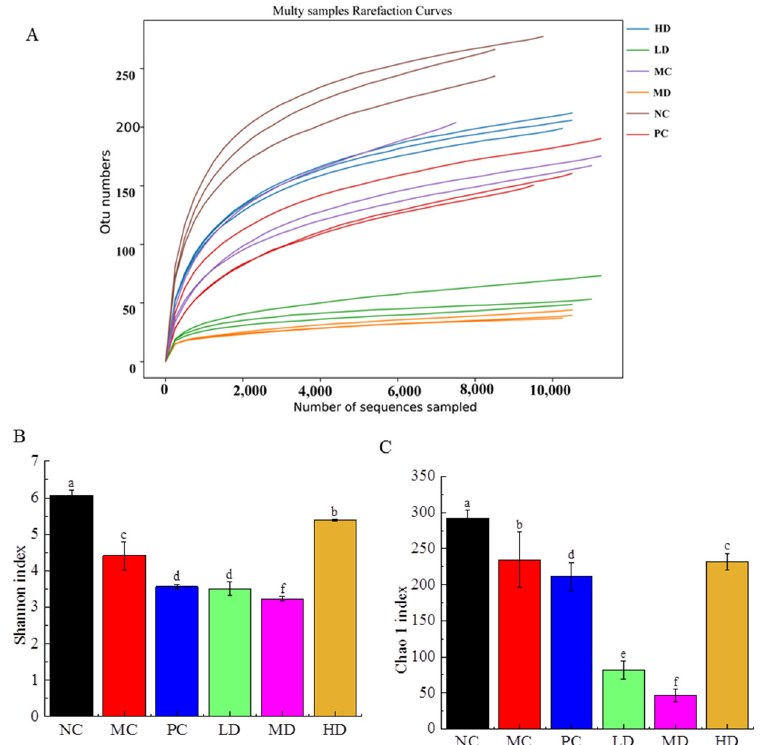
Figure 6. Rarefaction curve, Shannon and Chao 1 index of sequencing reads of the bacterial 16S rDNA gene from the cecum contents samples. ( A ) OUT numbers, ( B ) Shannon indexes, ( C ) Chao 1 indexes. Values are displayed as a bar chart plot with means (expressed as ‘+’), n = 3. a–f: bars with different letters are significantly different at p < 0.05 by Tukey’s post hoc test. NC: normal group (normal feed, 0.9% saline); MC: model group (HFD, 0.9% saline); PC: positive group (HFD, 0.5 mg/mL xuezhikang capsules); LD: RFV low dose group (HFD, 10% RFV); MD: RFV medium dose group (HFD, 30% of RFV); HD: RFV high dose group (HFD, 50% of RFV).